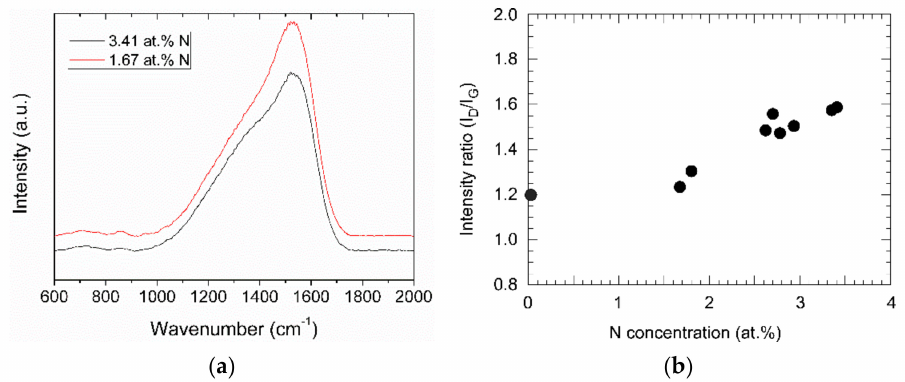
Figure 7. ( a ) Raman spectra of two N-DLC samples with di ff erent nitrogen contents; ( b ) area ratio I D / I G of the D and the G peak from the Raman spectra vs. nitrogen concentration of the (N-)DLC samples.